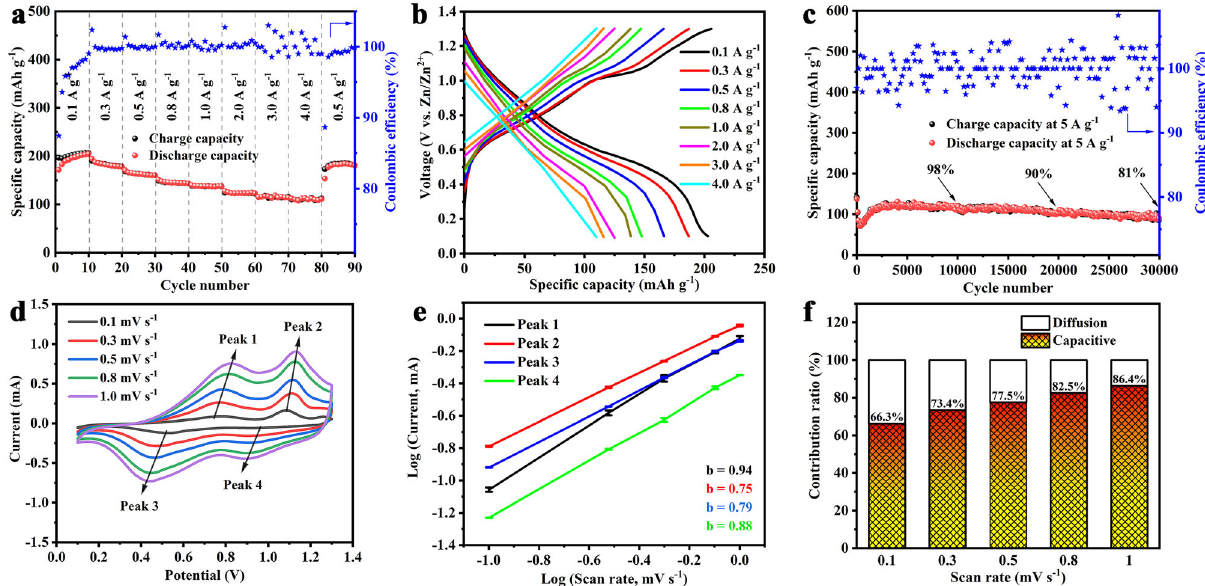
Fig. 3 Electrochemical energy storage performance of Zn||V d – V 2 O 3 cells. a Rate performance at different speci fi c currents for V d – V 2 O 3 . b Galvanostatic discharge pro fi les of V d – V 2 O 3 at increasing speci fi c currents from 0.1 to 4 A g − 1 . c Long-term cycling performance and coulombic ef fi ciency for V d – V 2 O 3 at a speci fi c current of 5 A g − 1 . d CV curves of the V d – V 2 O 3 at scan rates ranging from 0.1 to 1 mV s − 1 . e Error bars plot of Log ( i ) versus log ( v ) plots at speci fi c peak currents (The R 2 values corresponding to the lines of peaks 1, 2, 3, and 4 are 0.9975, 0.9998, 0.9998, and 0.9995, respectively). f Contribution ratios of capacitive and diffusion-controlled capacities at different scan rates from 0.1 mV s − 1 to 1.0 mV s − 1